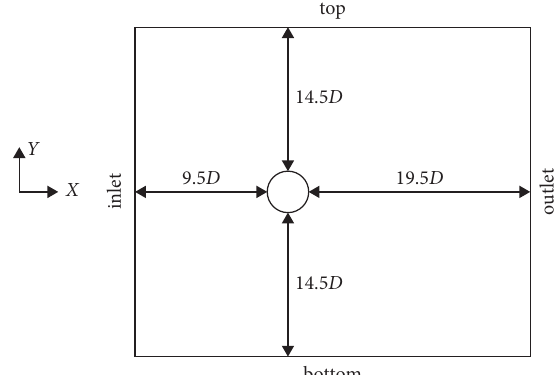
Figure 1: The calculational geometry.